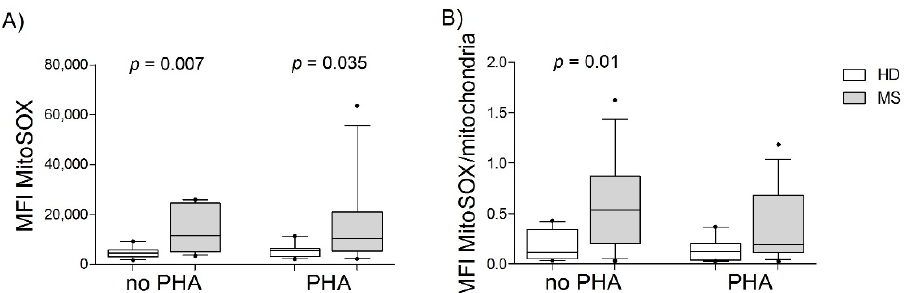
Figure 2. Mitochondrial ROS in PBMCs from multiple sclerosis (MS) patients and healthy donors (HD). ( A ) Mitochondrial superoxide anion production was measured using MitoSOX by flow cytometry. ( B ) Mitochondrial superoxide anion production was analyzed per mitochondrial content (MitoSOX/Mitotracker Green). No PHA: HD = 12, MS = 12; PHA: HD = 12, MS = 14. MFI: mean fluorescent intensity; PHA = phytohemagglutinin. P-values were calculated using the Mann-Whitney U test. In the box plots, the box boundary closest to zero indicates the 25th percentile, the line within the box marks the median, and the box boundary farthest from zero indicates the 75th percentile. Whiskers above and below the box indicate the 10th and 90th percentiles.